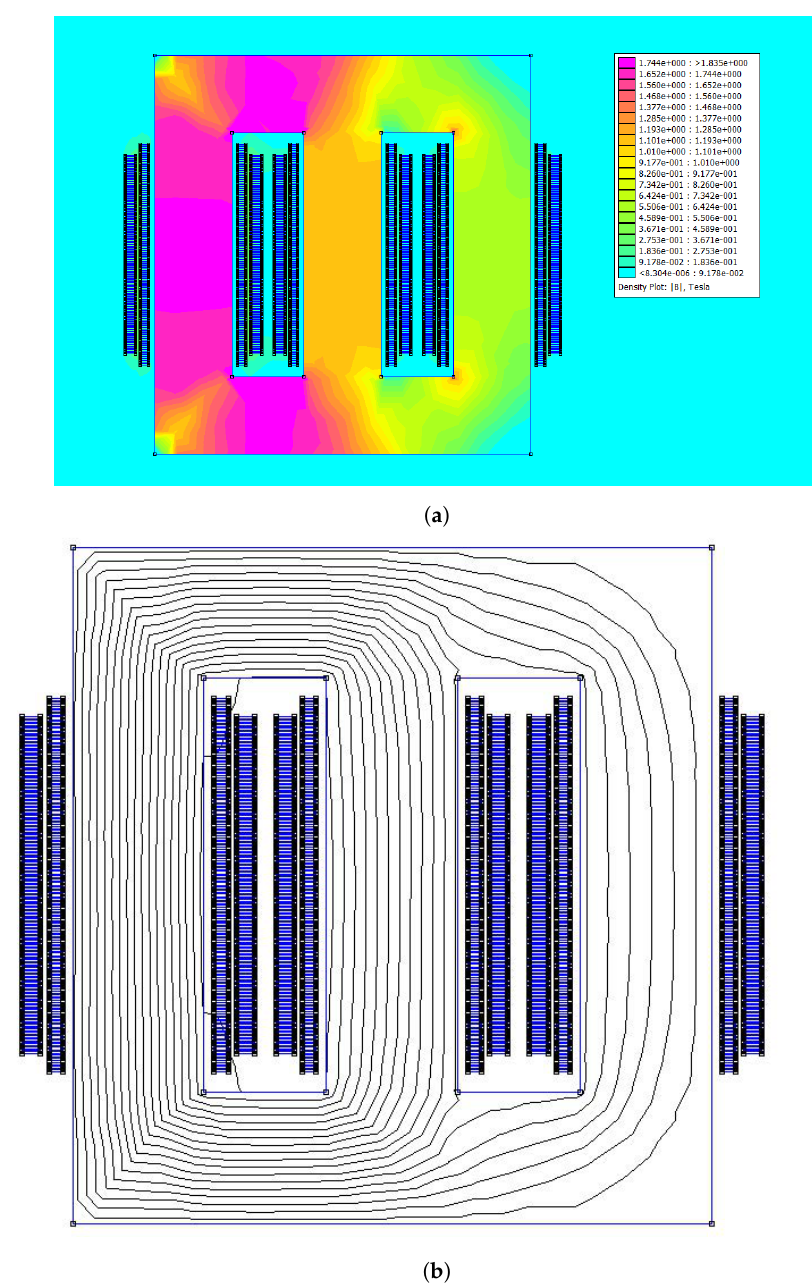
Figure 3. Magnetic induction for rated current. ( a ) Magnetic induction; ( b ) Flux